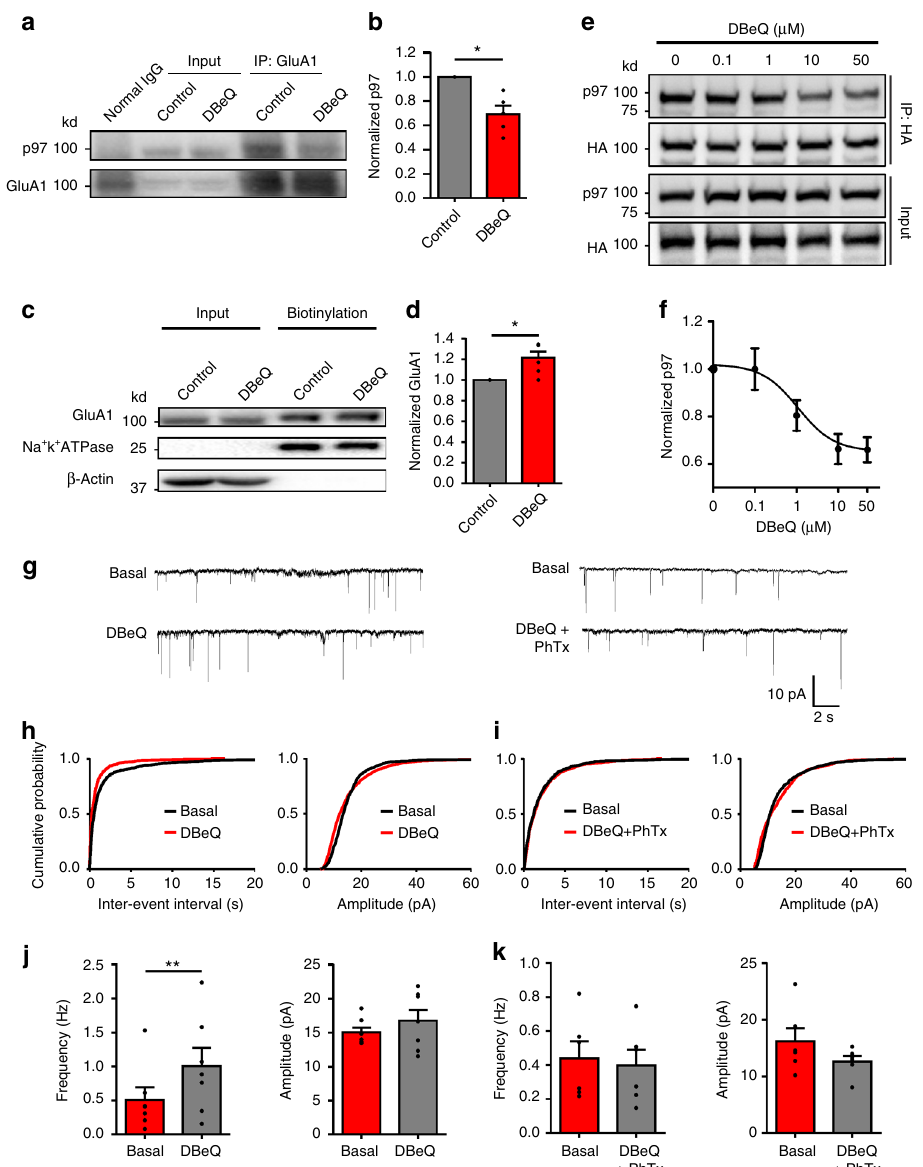
Fig. 6 p97 modulates native GluA1-homo AMPAR traf fi cking in hippocampal slices. a – d Neuronal cultures were treated with DBeQ in the bath (11 μ M; 30 min). Sequential immunoblotting for p97 and GluA1 in the anti-GluA1 co-immunoprecipitates ( a ) and bar graph of grouping data ( b ; n = 5 repeated experiments) demonstrate that inhibition of p97 with DBeQ signi fi cantly decreased the p97-GluA1 interaction; sequential immunoblots following biotinylation for surface GluA1 and Na + K + -ATPase, with β -actin as an intracellular protein control ( c ) and bar graph of grouping data ( d ; n = 6 repeated experiments) reveal that disrupting the p97 – GluA1 interaction by DBeQ released GluA1-homo AMPARs from intracellular reserve pool into the plasma membrane of neurons (* p < 0.05, two-tailed t test). e , f DBeQ disrupts p97-GluA1 interaction. COS7 cells were transfected with p97 and HA-GluA1, treated with different doses of DBeQ (in DMEM; 0, 0.1, 1, 10, 50 μ M; 30 min), and co-immunoprecipitated by anti-HA antibody. Sequential immunoblotting for p97 and GluA1 ( e ) and dose-response curve ( f ) of grouping data show that DBeQ dissociates p97 – GluA1 interaction in a dose-dependent manner,